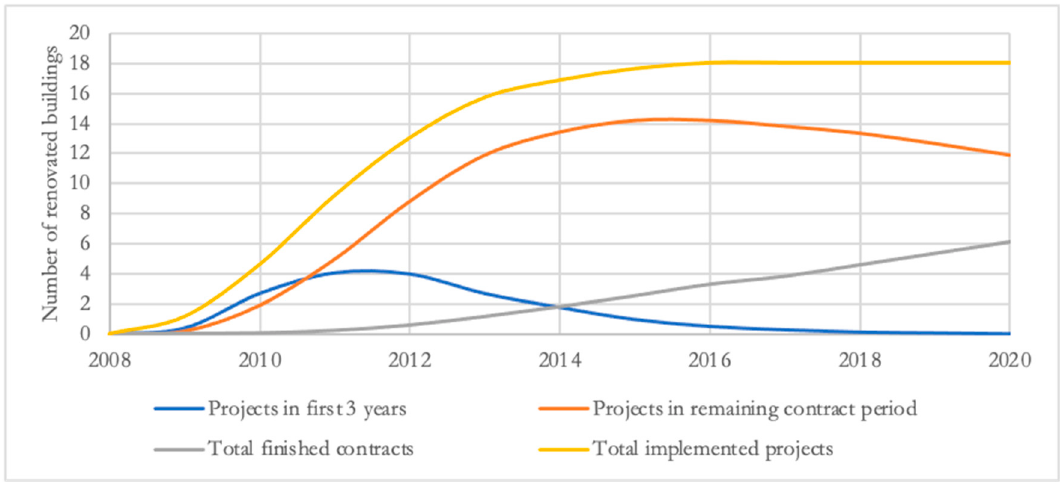
Figure 16. Simulated number of ESCO-renovated buildings with actual policy tools in place if no reinvestment fund is available.